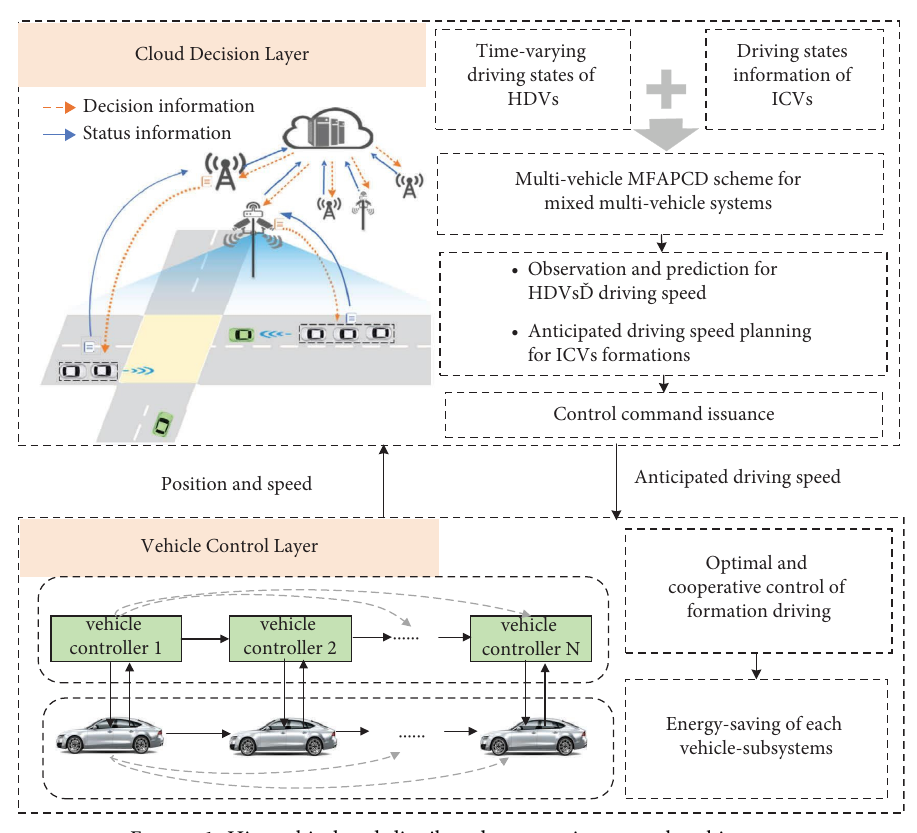
Figure 1: Hierarchical and distributed cooperative control